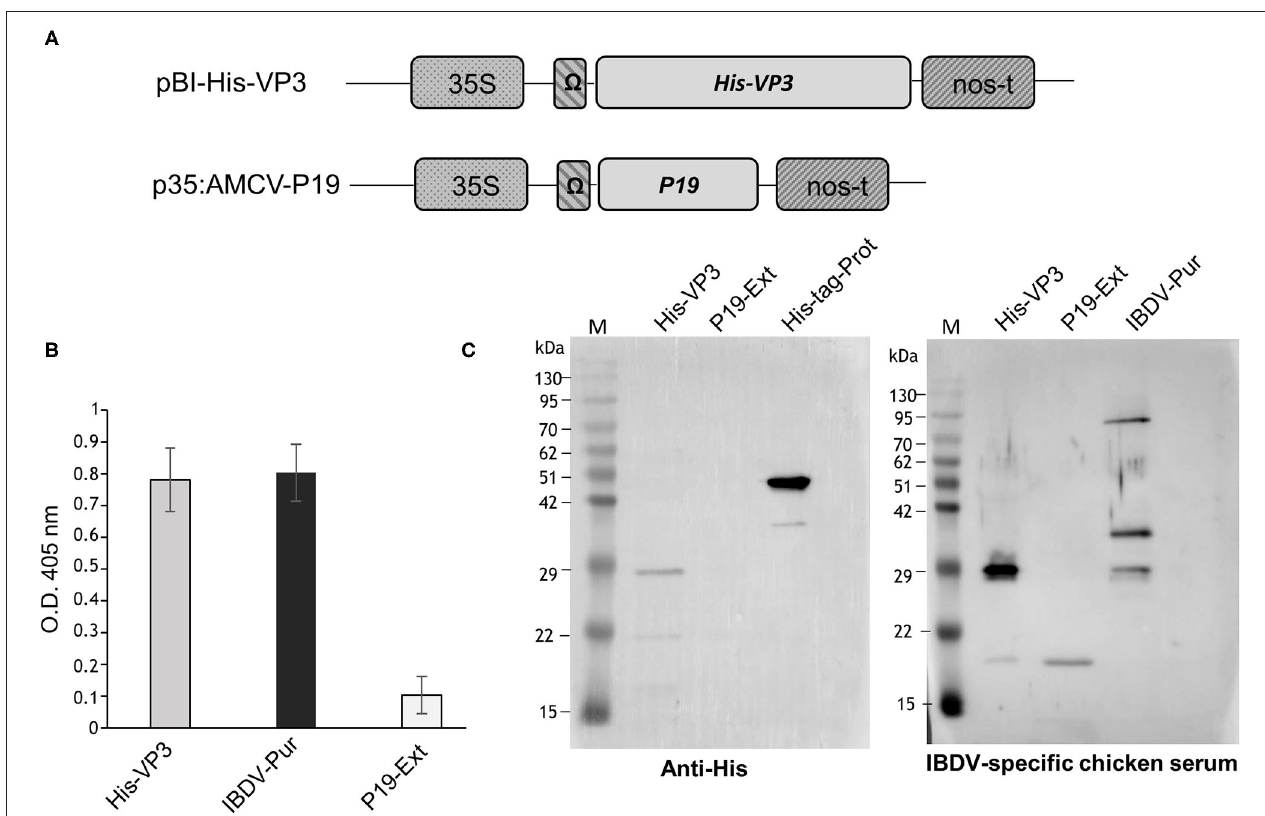
FIGURE 1 | Expression of His-VP3 in N. benthamiana plants. (A) Schematic representation of pBI-His-VP3 and p35:AMCV-P19 plant expression vectors. 35S: CaMV 35S promoter; Ω : TMV translational enhancer sequence; His-VP3 : sequence encoding the IBDV VP3 protein N-terminally fused to a 6X histidine tag; P19 : sequence encoding the AMCV p19 gene-silencing suppressor; nos-t: Nopaline synthase terminator from A. tumefaciens . (B) ELISA assay of TSP extracted from leaves agroinfiltrated with pBI-His-VP3 and p35:AMCV-P19 and collected at 7 DPI. Fifty µ g of TSP were distributed in triplicate into the wells, and His-VP3 was detected with a chicken anti-IBDV serum. The reported values are the mean of three independent experiments, and error bars represent the SD of the means. IBDV-Pur: wells coated with purified inactivated IBDV (30 ng/well); P19 Ext: wells coated with the extract from leaves agroinfiltrated only with p35:AMCV-P19, used as the negative control. (C) Western blot analysis of His-VP3 expression in leaf extracts. Ten µ g of TSP was separated by 12% SDS-PAGE. Left panel: His-VP3 detection using an anti-His antibody. M: A protein molecular weight marker; His-VP3: His-VP3 plant extract; P19 Ext: extracts from leaves agroinfiltrated only with p35:AMCV-P19, used as negative control; His-tag-Prot: unrelated His-tagged protein used as the positive control. Right panel: His-VP3 detection using the chicken anti-IBDV serum. M: A protein molecular weight marker; His-VP3: His-VP3 plant extract; P19 Ext: extracts from leaves agroinfiltrated only with p35:AMCV-P19, used as negative control; IBDV-Pur: purified inactivated IBDV used as the positive